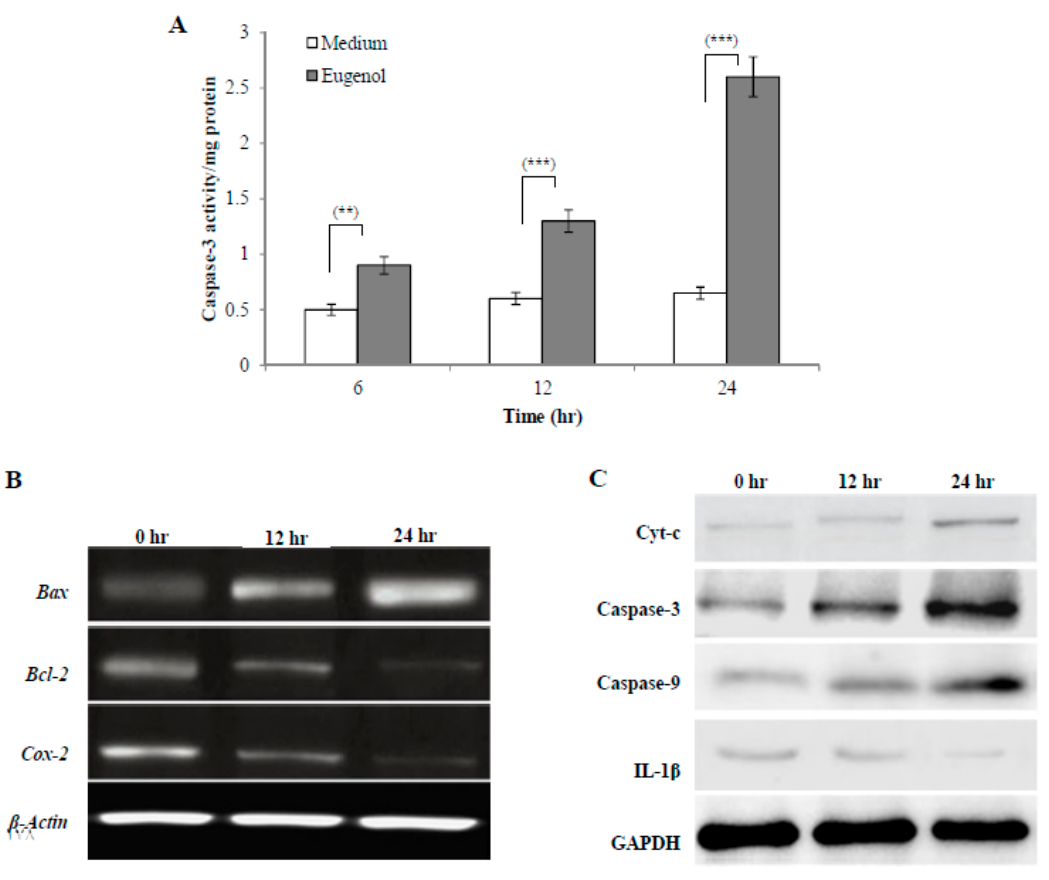
Figure 4. Effect of eugenol on cell signaling of HeLa cells. ( A ) Eugenol increases caspase-3 activity in HeLa cells. HeLa cells were treated with medium or eugenol (350 µM)-containing medium for 6, 12, or 24 h. Activity was detected by a caspase-3 colorimetric activity assay kit. Data, obtained from three independent experiments, represent mean ± SD. Significant difference was analyzed by one-way ANOVA test, where ** p < 0.01 and *** p < 0.001 compared to HeLa cells treated with medium only. ( B ) Effect of eugenol on Bax , Bcl - 2 , and Cox - 2 gene expression in HeLa cells. HeLa cells were treated with medium or eugenol (350 µM)-containing medium for 12 or 24 h. β -actin was used as the internal control. ( C ) Effect of eugenol on Cyt-c, caspase-3, caspase-9, and IL-1 β protein expression in HeLa cells. Representative immunoprecipitation blots of protein expression of HeLa cells treated with medium or eugenol (350 µM)-containing medium for 12 or 24 h. GAPDH was used as the internal control.